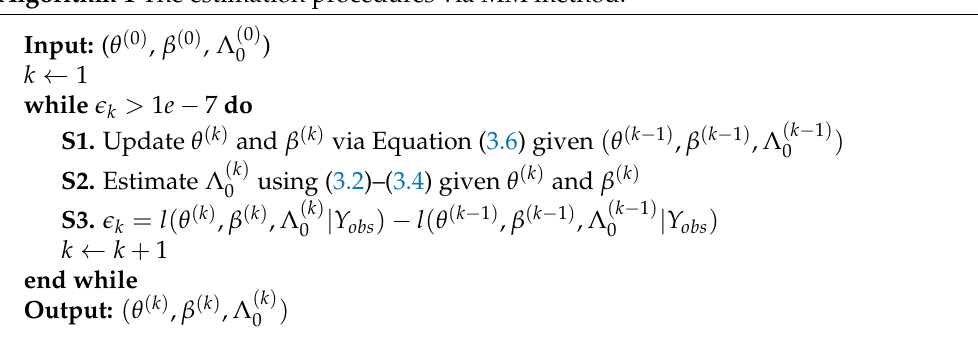
Algorithm 1 The estimation procedures via MM